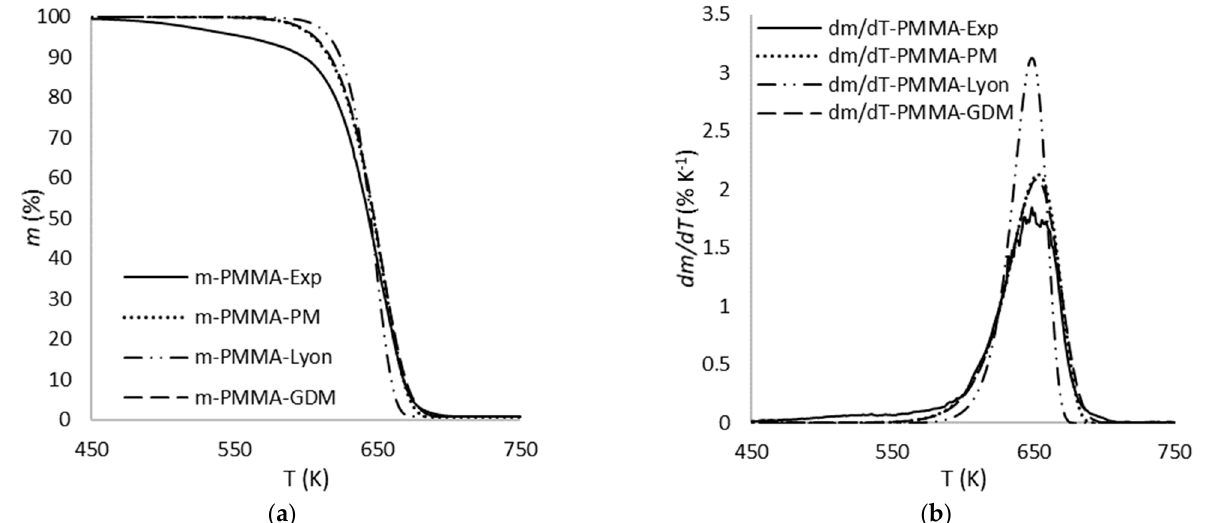
Figure 13. A comparison of experimental and calculated ( a ) mass and ( b ) dm / dT results for PMMA.